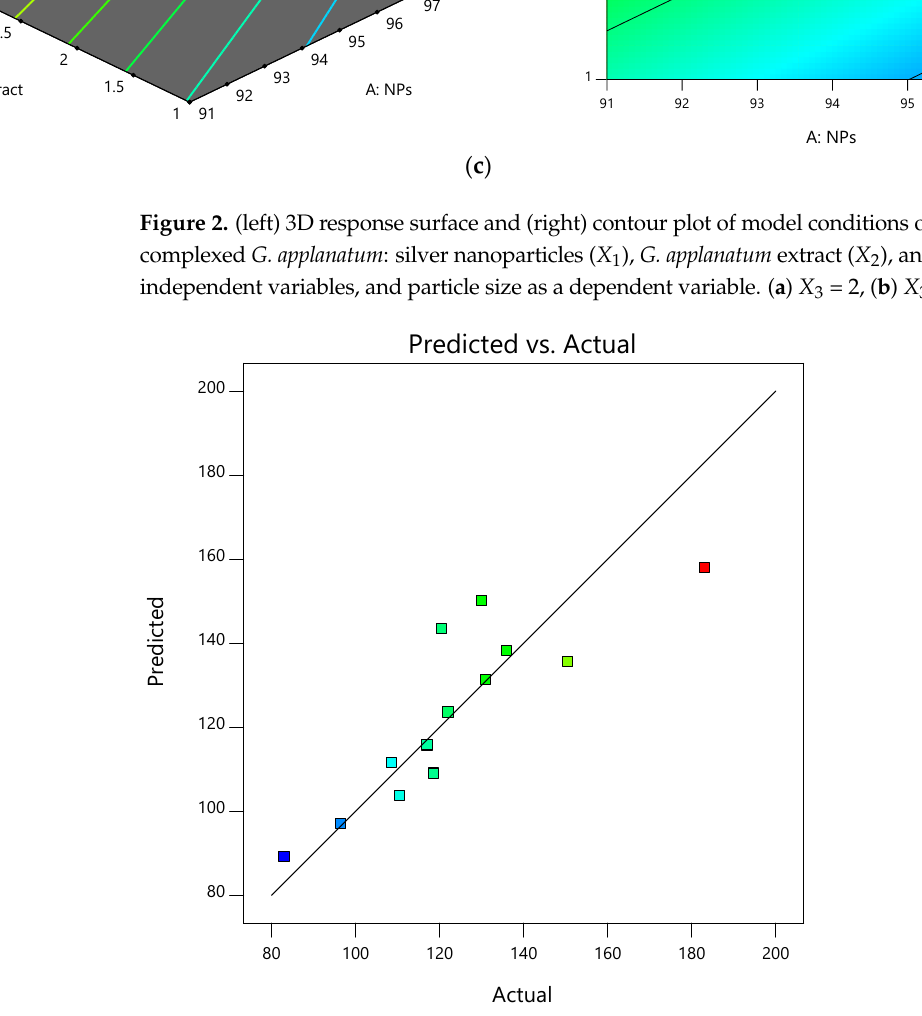
Figure 3. Predicted versus actual plots of model conditions of silver-nanoparticle-complexed G. applanatum : silver nanoparticles ( X 1 ), G. applanatum extract ( X 2 ), and ionic liquid ( X 3 ) as independent variables, and particle size as a dependent variable.